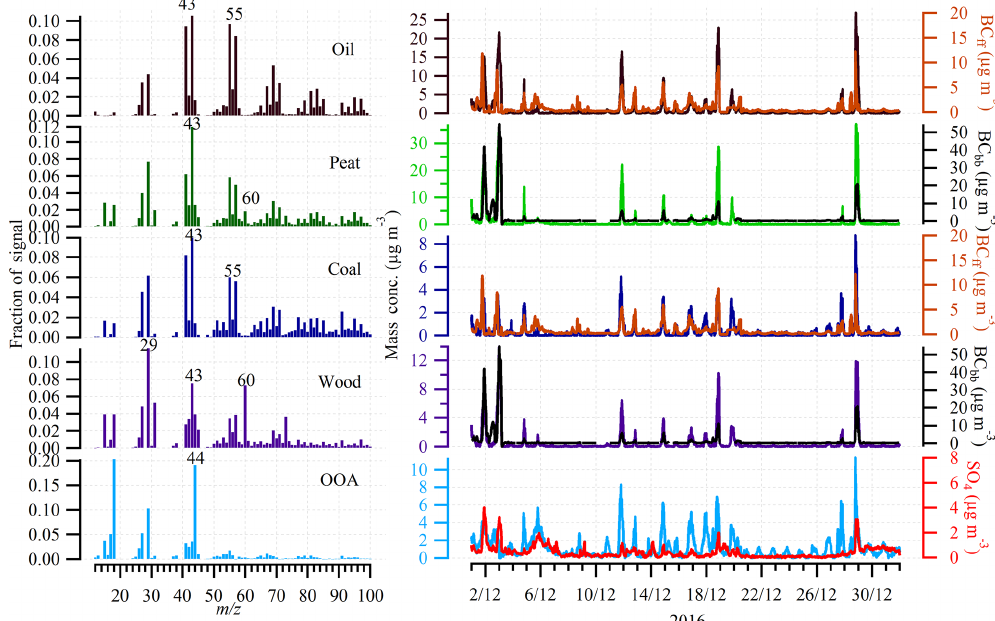
Figure 3. Profiles and time series of HOA, peat, coal, wood, and oxygenated OA (OOA) at the urban site in Dublin in December 2016. The time series of BC from traffic (BC tr ), BC from wood burning (BC wb ), and sulfate (SO 4 ) were also included to support OA source